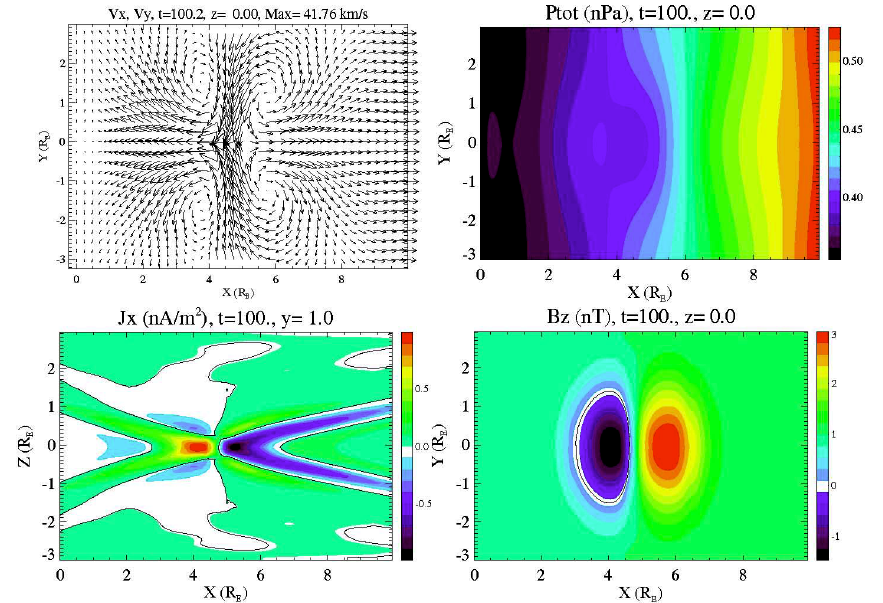
Fig. 6. Fields at 100s into the run based on the equilibrium model in Fig. 5. (a) Top left: velocity vectors in the z =0 plane; (b) Top right: Total pressure contours for the z =0 plane; (c) Bottom left: Contours of the Earthward current at the y =1 plane; and (d) Bottom right: Contours of the B z magnetic field.